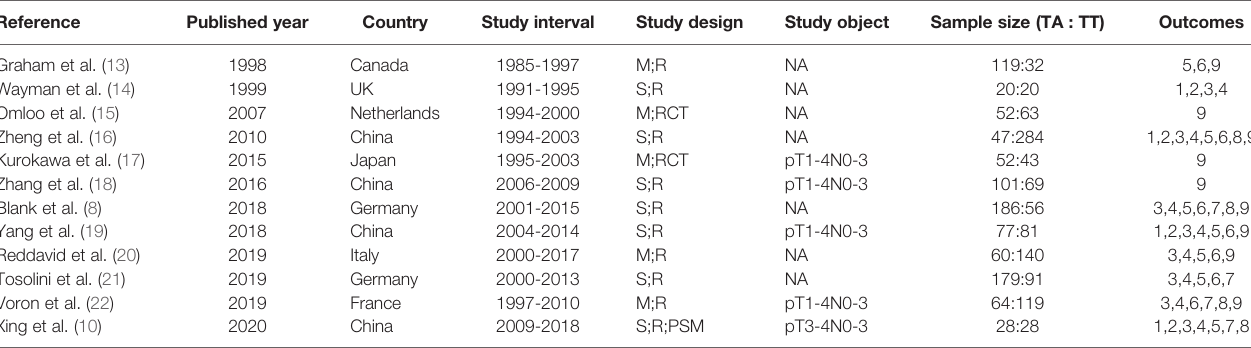
TABLE 1 | Characteristics of included